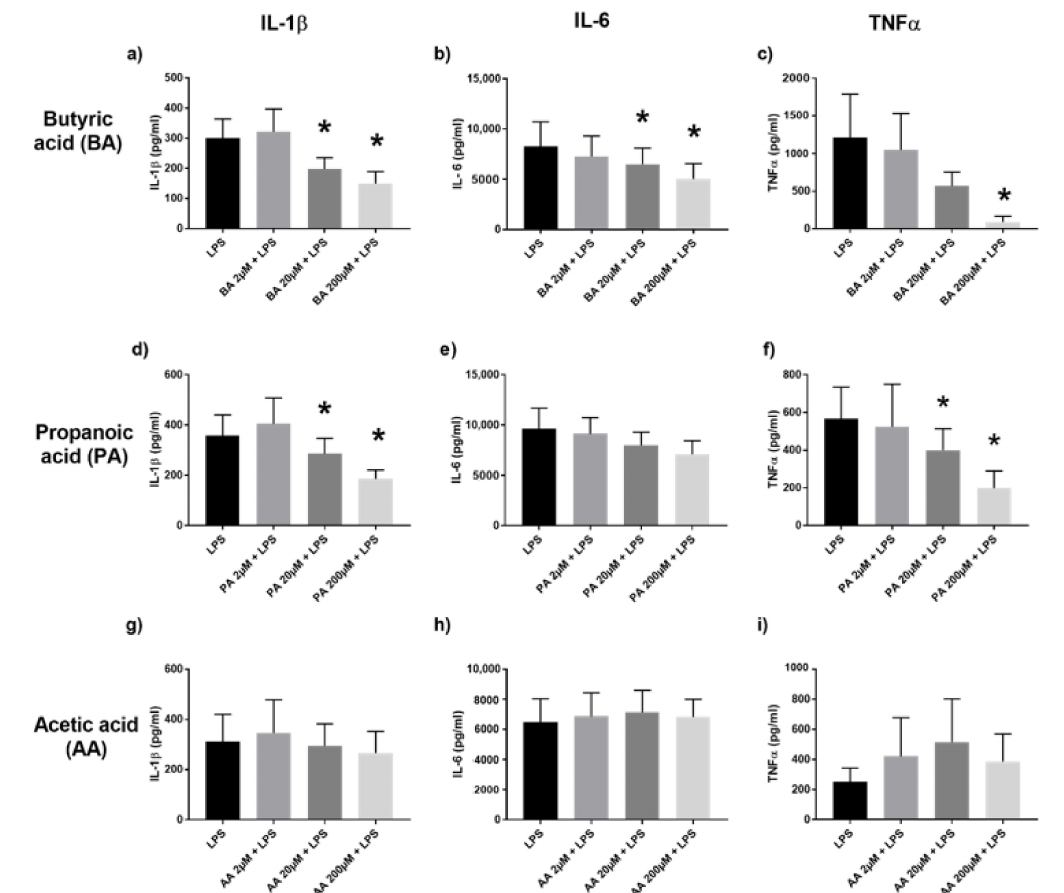
Figure 1. Cytokine production of IL-1 β , IL-6 and TNF α in the supernatants of PBMC stimulated with LPS and 2, 20, 200 µ M of SCFA, assessed by Enzyme-Linked Immunosorbent Assay (ELISA). Human PBMC were co-incubated with LPS and butyric acid (BA) ( a – c ), propanoic acid (PA) ( d – f ), or acetic acid (AA) ( g – i ). Values are presented as mean ± standard error of the mean (SEM), results from at least 7 subjects were used. Wilcoxon signed rank test to determine significance for pair-wise comparisons with the LPS control, * p < 0.05 is the cytokine level difference compared to the control LPS group (black